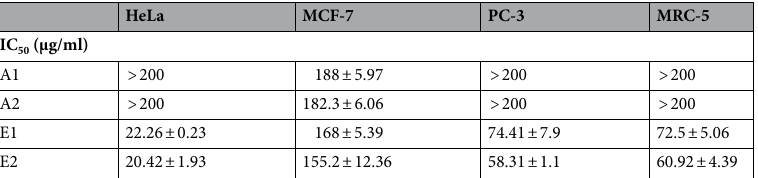
Table 4. Cytotoxic activity (IC 50 values) of aqueous and ethyl acetate extracts of stems, leaves and flowers (A1 and E1, respectively) and leaves and flowers (A2 and E2, respectively) of S. kitaibelii against human cancer cell lines. IC 50 values (μg/mL) are expressed as the mean ± SD determined from the results of MTT assay in three independent